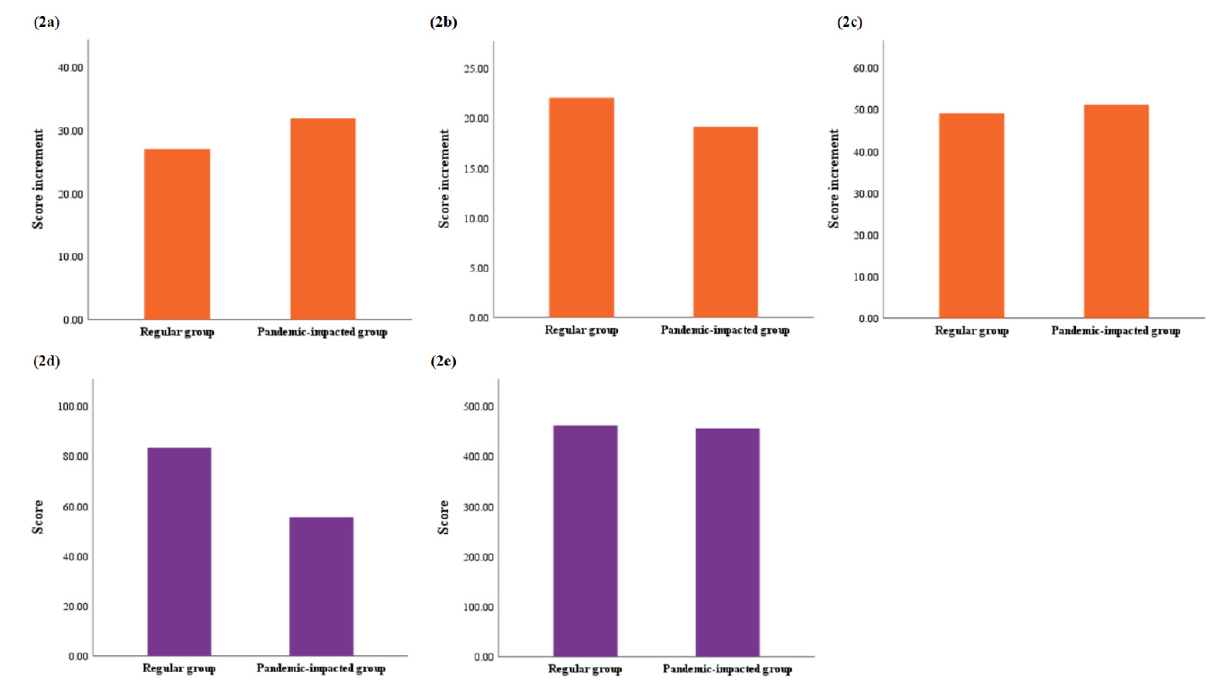
Figure 2. Score increment of skill-based stations and Score in standardized patient-based station. ( 2a ) Score increment of skill-based stations between first mock OSCE and second mock OSCE, p = 0.564; ( 2b ) Score increment of skill-based stations between second mock OSCE and national OSCE, p = 0.706; ( 2c ) Score increment of skill-based stations between first mock OSCE and national OSCE, p = 0.781; ( 2d ) National OSCE score comparison of standardized patient-based station associated with emergency medicine, p < 0.001; ( 2e ) National OSCE score comparison of standardized patient-based station not associated with emergency medicine, p = 0.477; Results were considered significant by p < 0.05. Table 2. Score increment between first mock OSCE and national